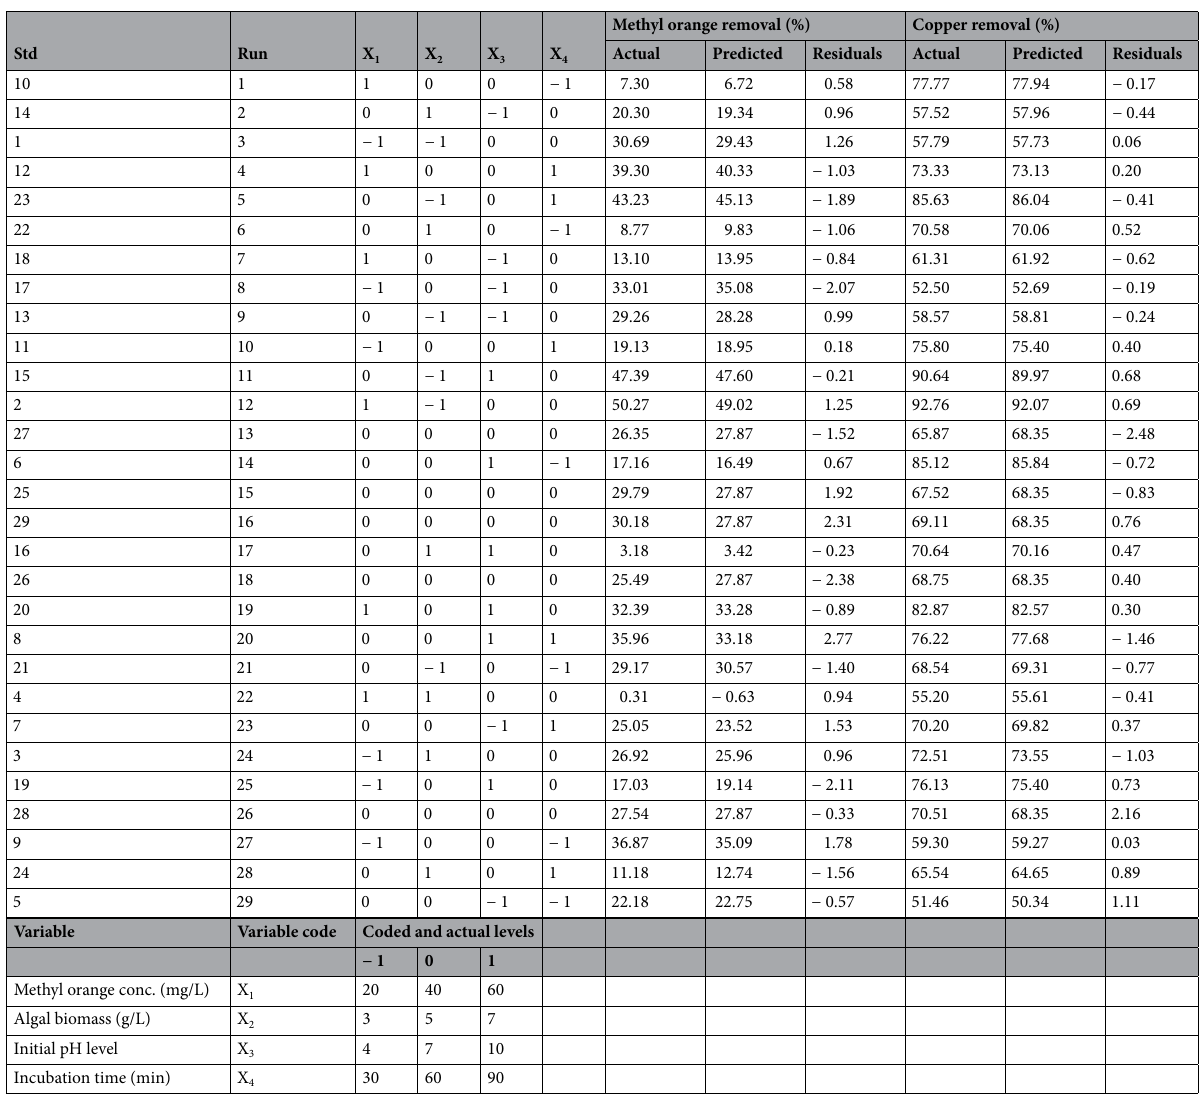
Table 1. Box–Behnken design matrix of four process variables with actual factor levels, coded factor levels, predicted and experimental values of simultaneous biosorption of methyl orange dye and copper (II) ions by using Fucus